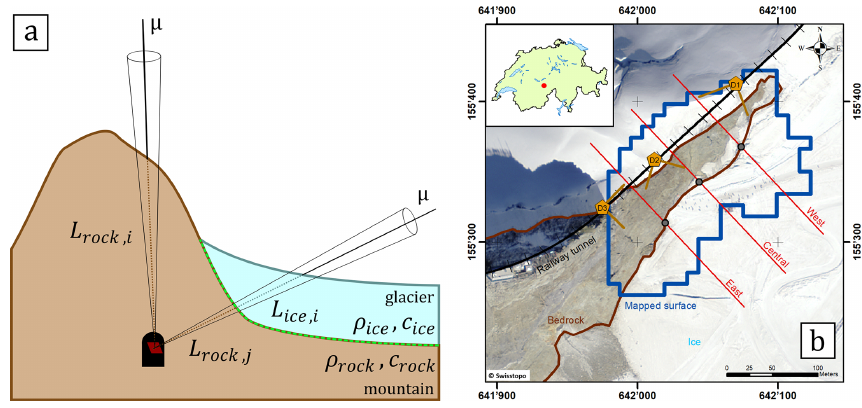
Figure 1. (a) Schematic side view of the experiment from Nishiyama et al. (2017). A muon detector (red) is placed in a tunnel or cavity and records muons from the cosmic-ray flux that penetrate the material (ice and rock) from different directions. Muons that are detected along cones yield information on the amount and density of matter between the topographic surface and the detector. Based on this, the interface between ice and rock (dashed green line) can be reconstructed. (b) Modified Fig. 1 from Nishiyama et al. (2017); overview of the study region in the central Swiss Alps. Detectors are indicated by yellow pentagrams (D1, D2, D3; including their view field) within the railway tunnel (black line). The imaged area is outlined in blue and the region that we know from the digital elevation model to contain only rock is marked in brown. We verified (see Sect. 4) the reconstruction in this study with the one from Nishiyama et al. (2017) along three cross sections (east, central, west; red lines). Basemap: Orthophotomosaic Swissimage, © Federal Office of Topography swisstopo.